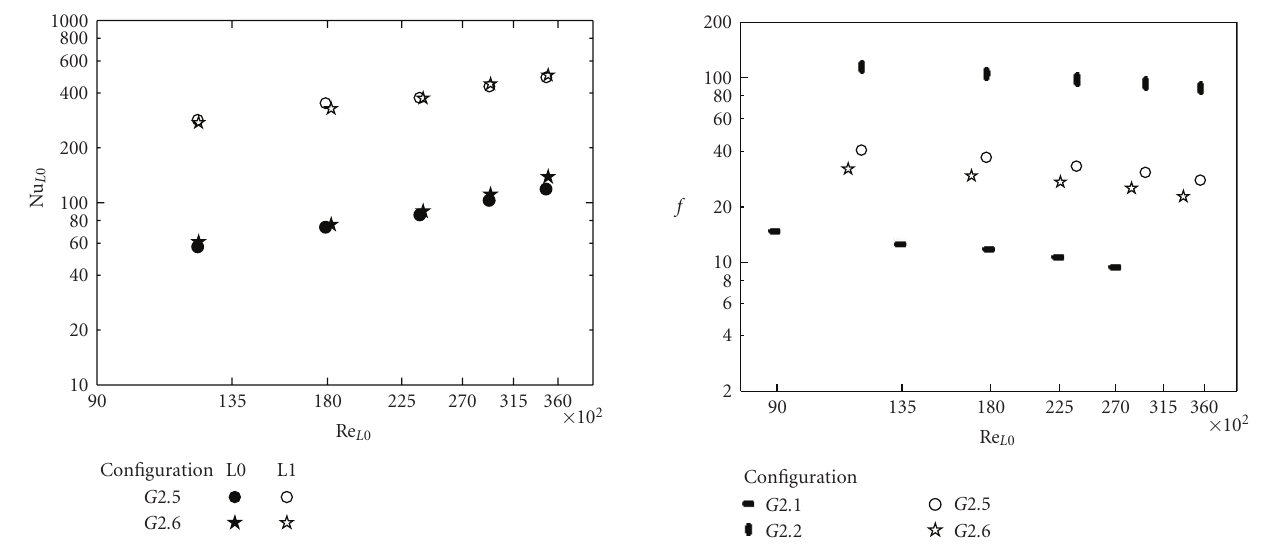
Figure 12: G 2.5 and G 2.6 data—Nu L 0 versus Re L 0 .